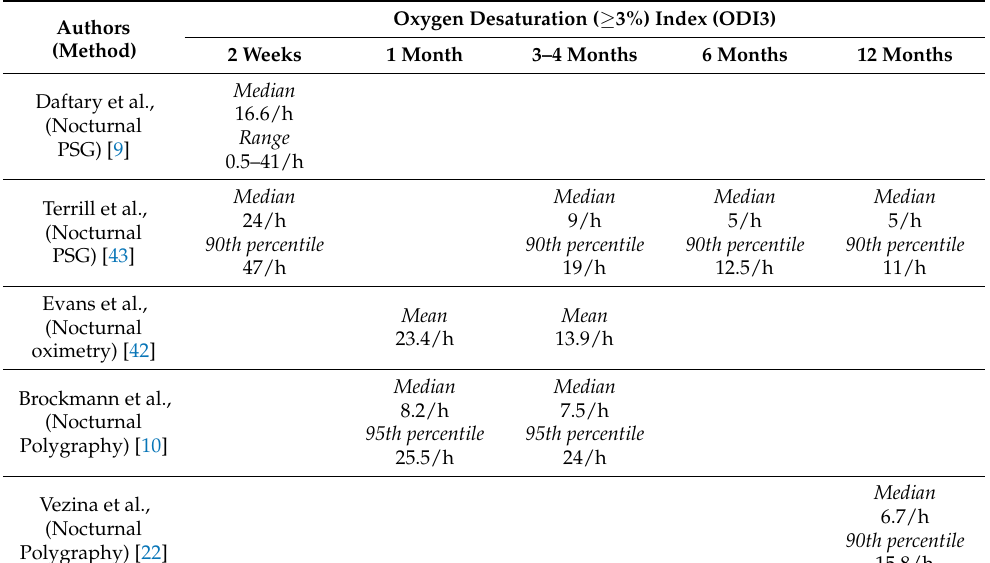
Table 2. Comparison of reference values for nocturnal oximetry parameters from various studies that recruited healthy